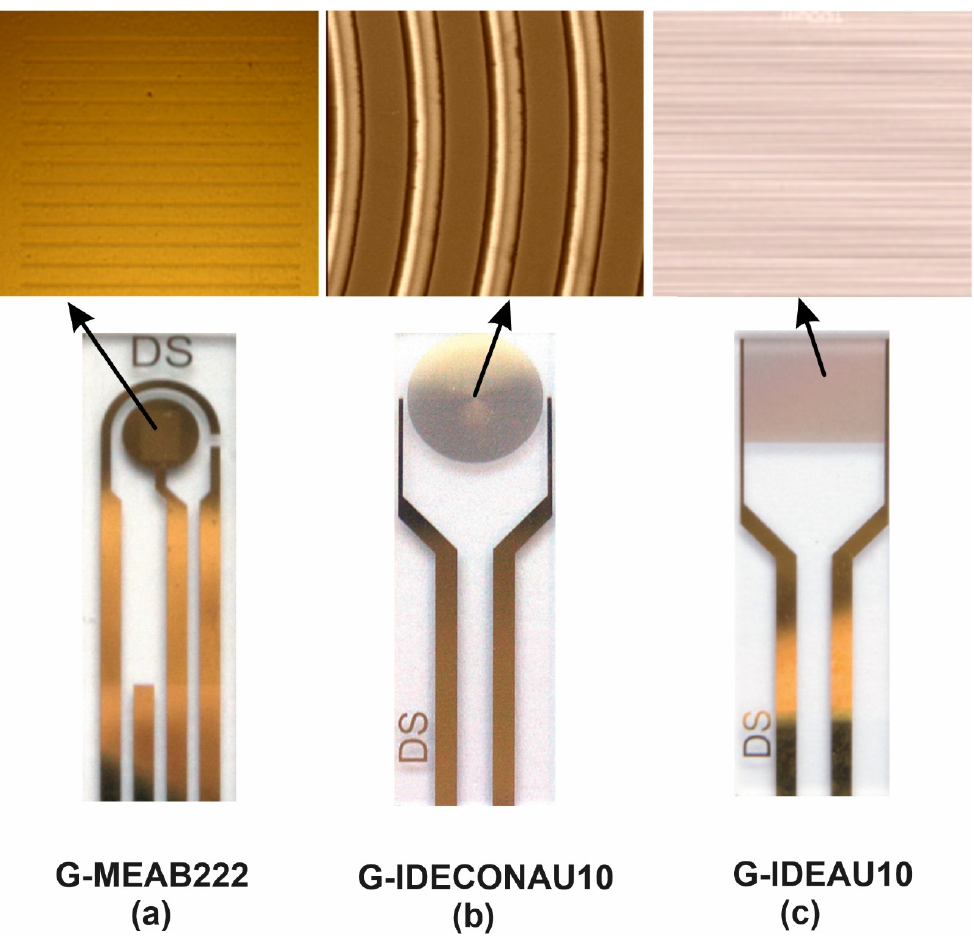
Figure 1. The three different electrodes were used for biosensing applications. From left to right: ( a ) G-MEAB222, the top photo shows the optical microscopy image of the design of the microarray electrode, and the bottom one shows the whole picture of the sensor [38]. ( b ) G-IDECONAU10, the top photo shows the scanning electron microscopy (SEM) image of the design of the concentric circles, and the bottom one shows the whole picture of the sensor [39]. ( c ) G-IDEAU10, the top photo shows the optical microscopy image of the capacitor array design, and the bottom one shows the whole sensor picture